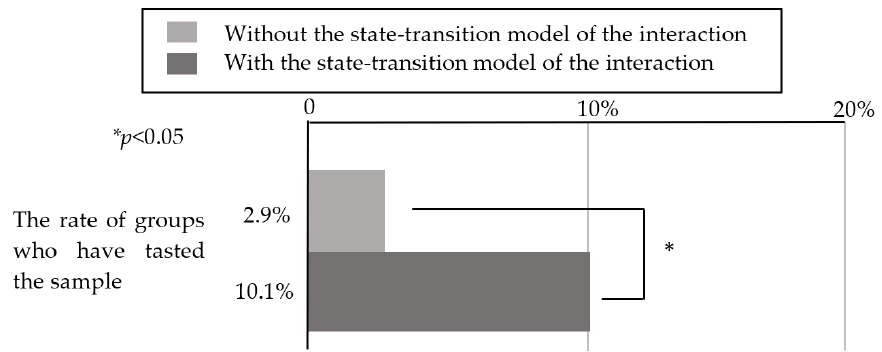
Figure 16. Percentage of customers who tasted a sample.